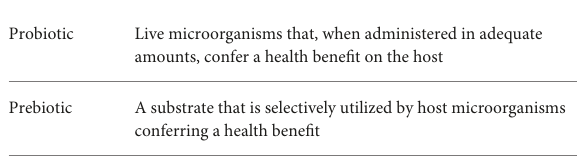
TABLE 1 Definitions of prebiotic (Gibson et al., 2017) and probiotic (Hill et al., 2014). Probiotic